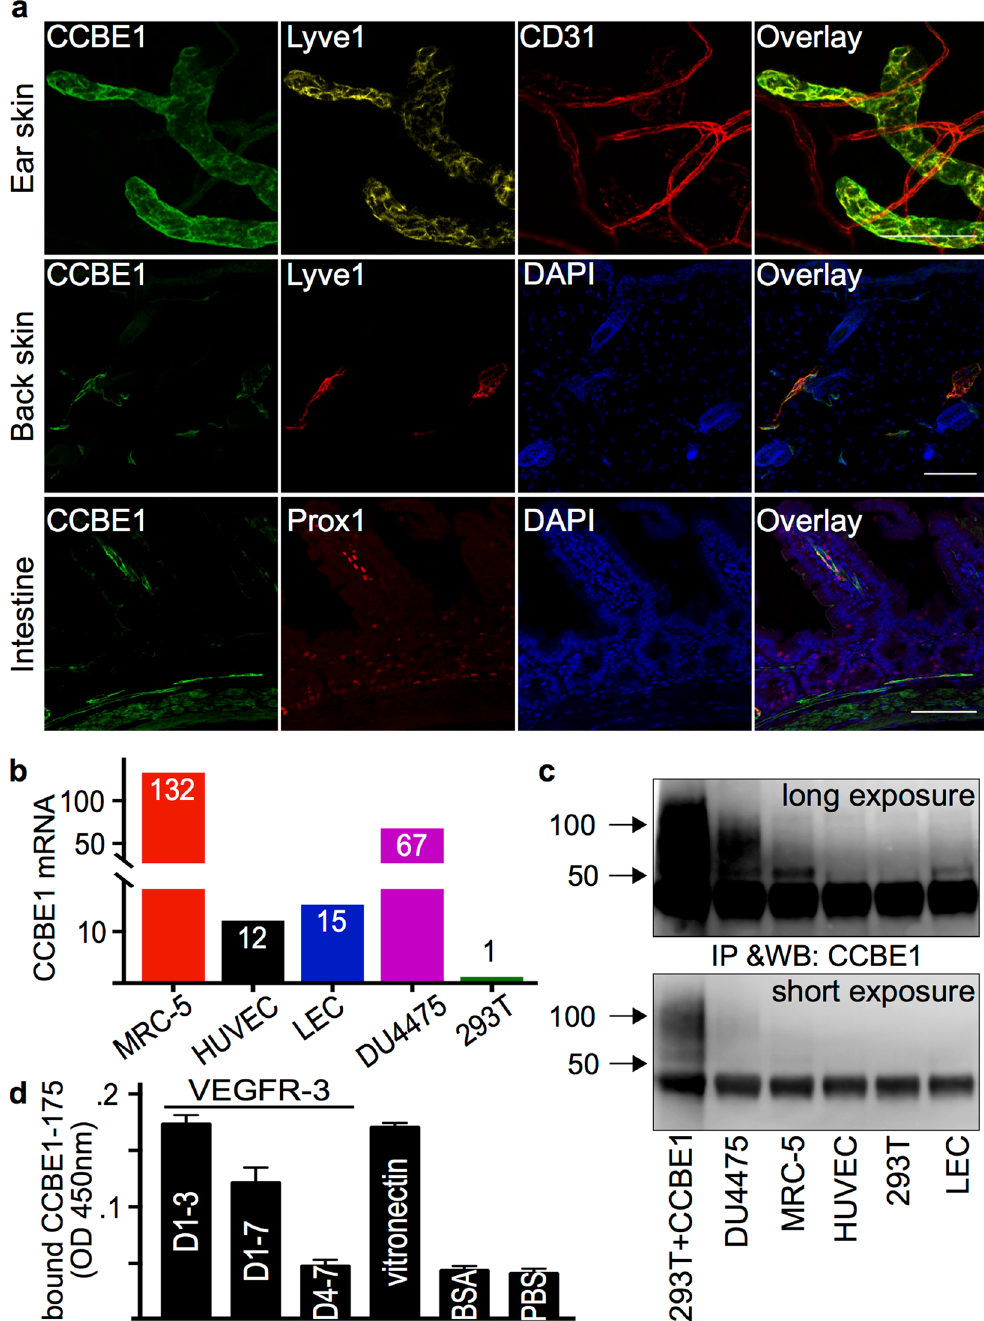
Figure 4. CCBE1 is expressed by fibroblasts and lymphatic endothelial cells, and localizes to lymphatic endothelial cell surface. ( a ) CCBE1 localization on the surface of lymphatic endothelial cells (LECs) in the mouse ear skin (whole mount staining), back skin and intestine (sections) as shown by co-staining with Prox-1 or Lyve-1. Expression of CCBE1 was analyzed by qPCR ( b ) and Western blotting ( c ). The full length blots are shown in the Supplementary Fig. S12. Among the primary cell lines analyzed, CCBE1 was expressed by LECs and HUVECs. From the tested cell lines, MRC-5 (fibroblast) and DU4475 (breast cancer) showed the highest expression of CCBE1. ( d ) In an assay with purified proteins, the N-terminal domain of CCBE1 (CCBE1-175) binds to immobilized VEGFR-3 and vitronectin. Binding to VEGFR-3 requires the presence of the VEGF-C binding domains of VEGFR-3 (immunoglobulin-like domains 1-3). Scale bars: 100 µ